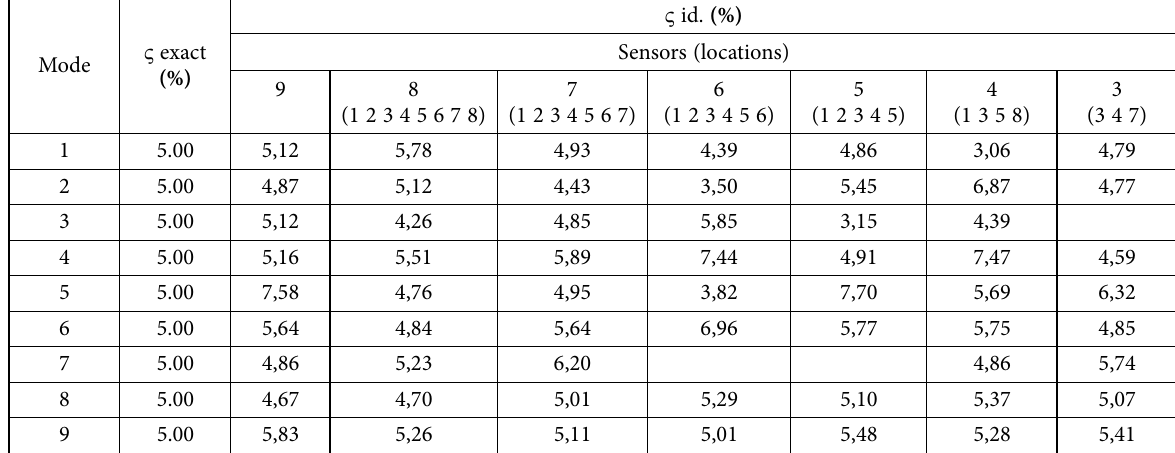
Table 3. The exact and identified damping ratios of the tripod simplex